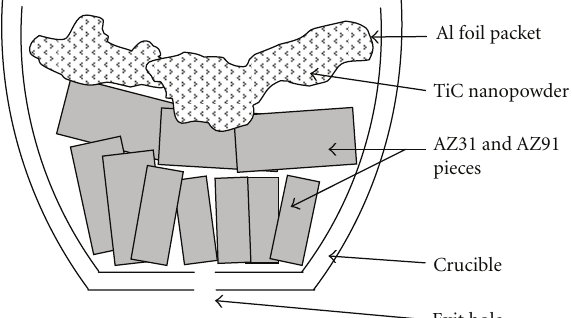
Figure 1: Arrangement of raw materials in crucible before casting for AZ31/AZ91/TiC